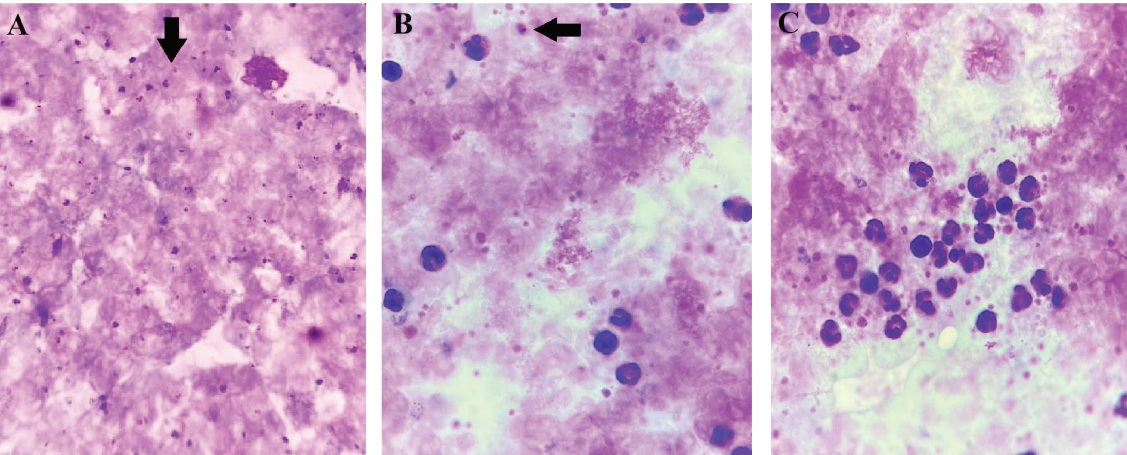
Figure 1: Peripheral blood smear of Plasmodium falciparum (arrows) legends. (a) Tick flm showed asexual stage of P. falciparum on day 1. (b) Te gametocytes of P. falciparum on day 3. (c) Asexual stage and gametocytes of P. falciparum were not found on day